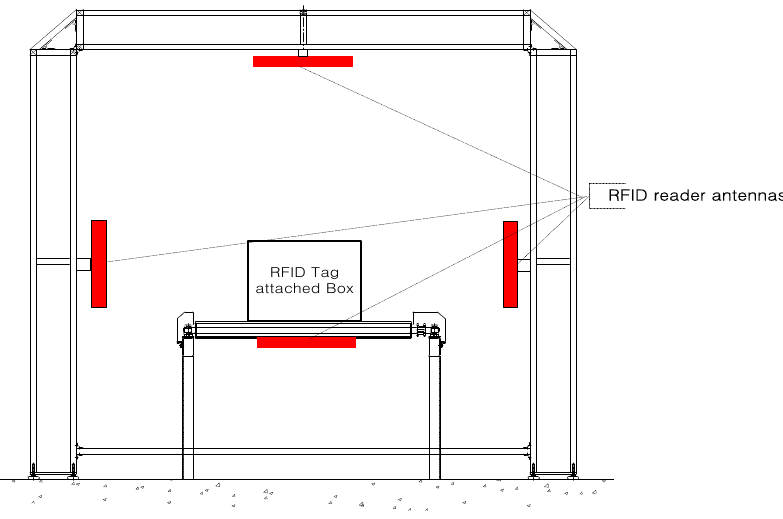
Figure 3. The RFID conveyor belt gate structure proposed by EPCglobal.